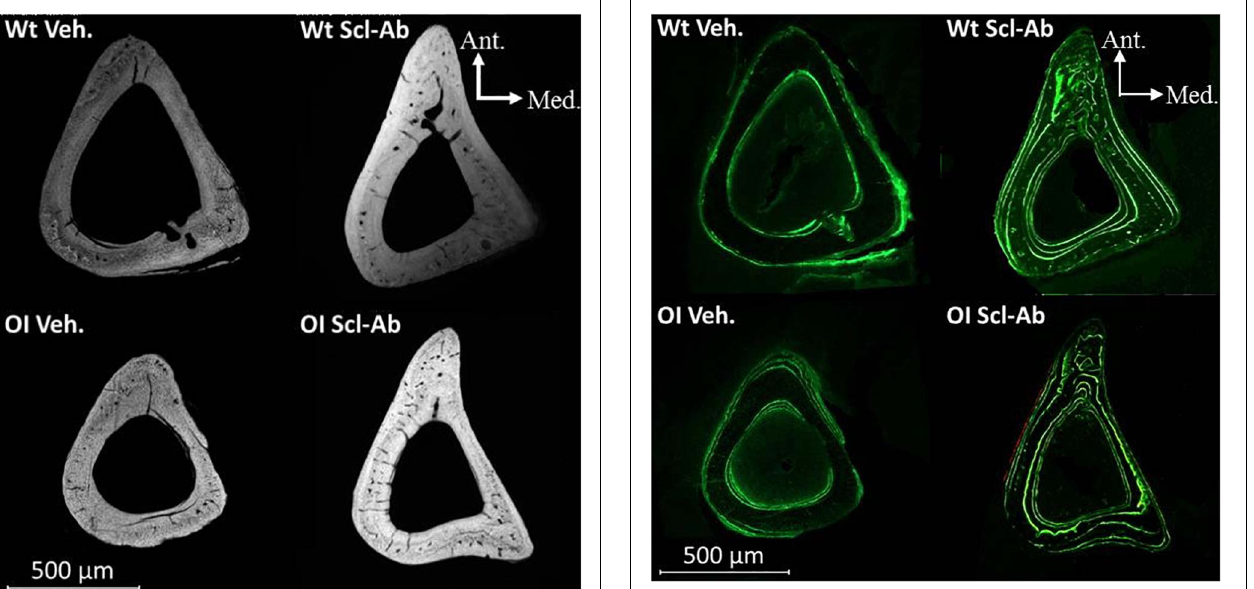
( + 13.4%) and in OI Veh. ( + 17.8%). BV/TV of the tibia was